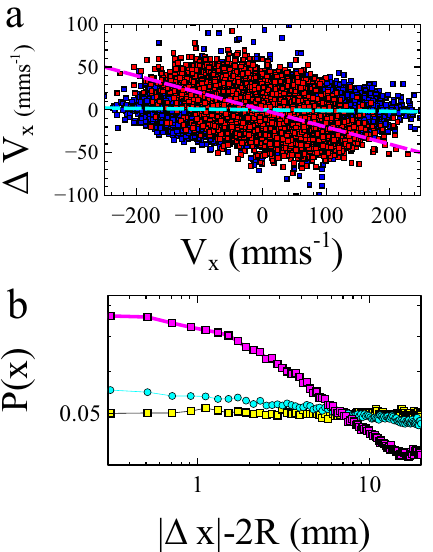
Figure 4. Simulations of 2 bouncing balls in a 60 mm wide periodic box. ( a ) frictional impulse due to a normal bounce (blue) and a bounce following a collision with the other ball (red). ( b ) Separation probability between the two particles on a log–log scale. We compare elastic collisions with (magenta) and without (yellow) rolling, and an inelastic collision without rolling (cyan). The relative contact velocity friction mechanism provides the most significant loss mechanism. (Figure prepared using Veusz https ://veusz .githu